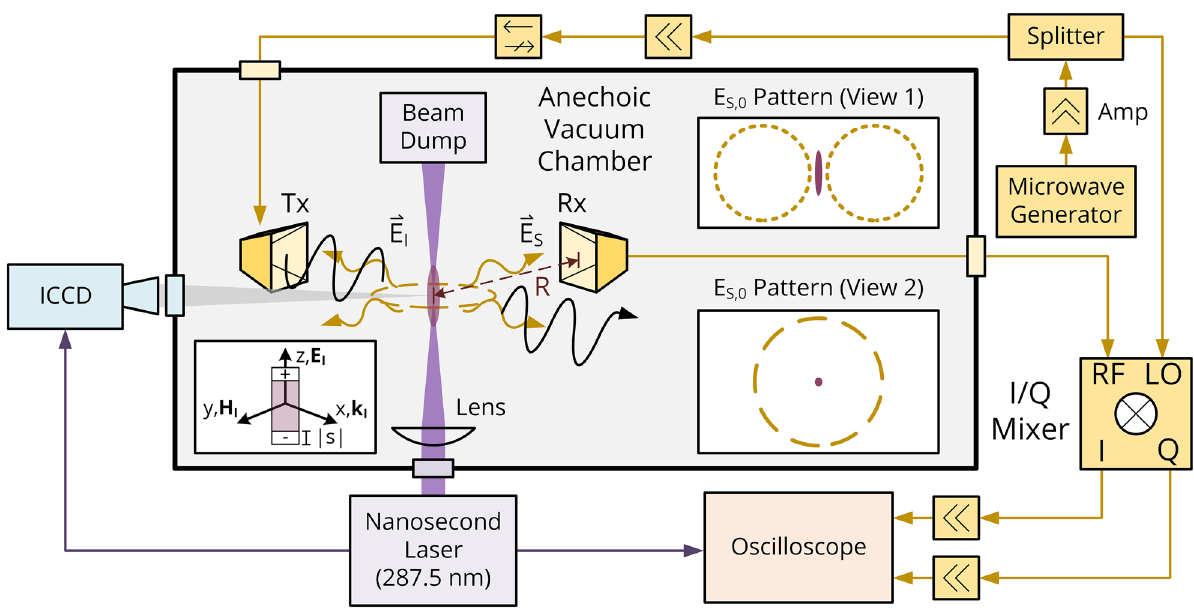
Figure 5. Experimental set-up. Conceptual illustration of in-phase coherent microwave scattering in the far- field by a short, thin plasma object—coupled with a general schematic of the photoionization (purple), plasma imaging (blue), and microwave scattering (yellow)